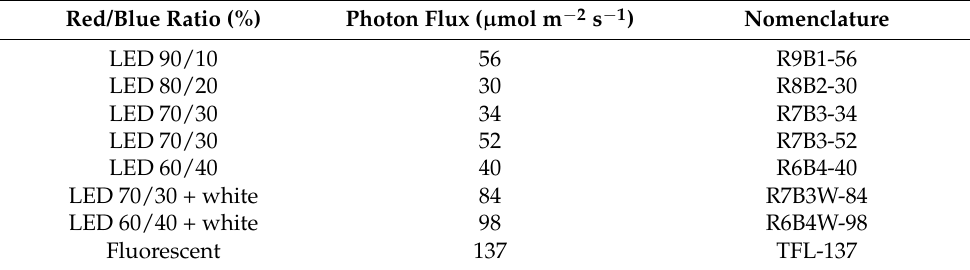
Table 1. Lighting conditions assayed in this